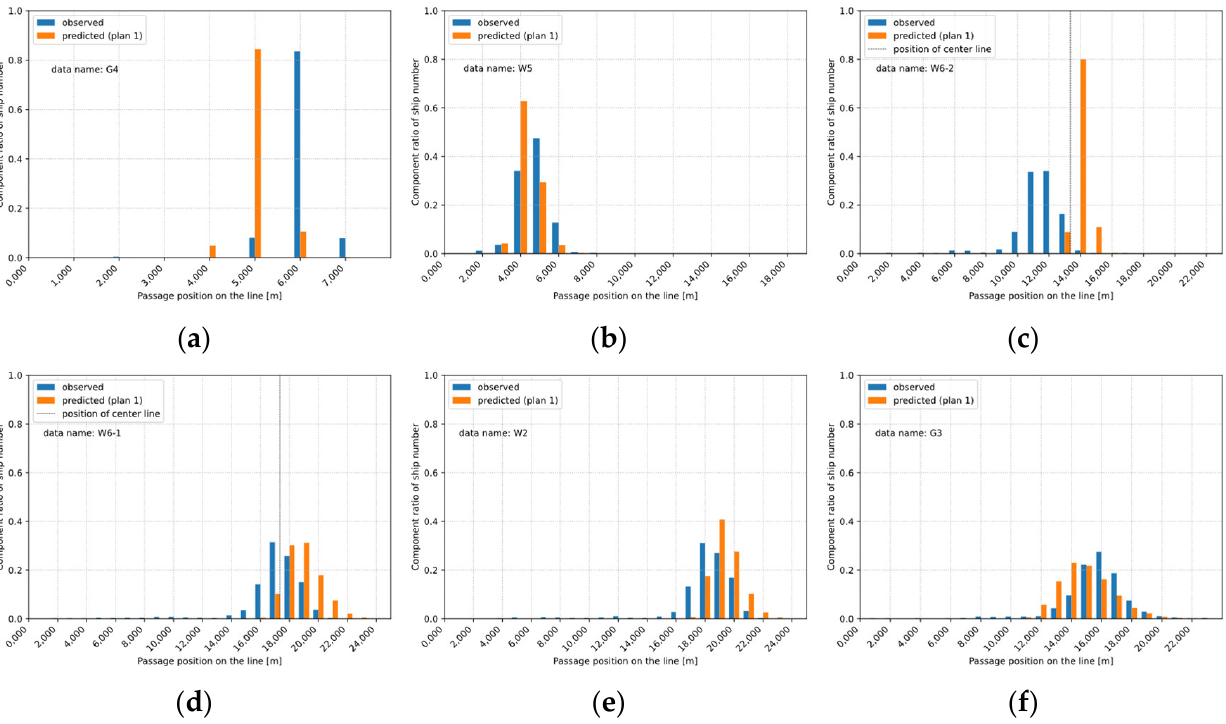
Figure 11. The present and future passage position distribution of category ID 0 for Plan 1: ( a ) Gate 4; ( b ) WP 4; ( c ) WP 3; ( d ) WP 2; ( e ) WP 1; and ( f ) Gate 3. Gates and WPs are shown in Figure 9.